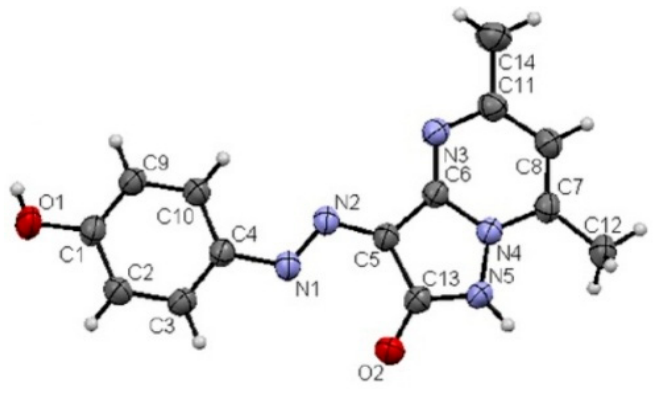
Figure 1. ORTEP of dye 5.